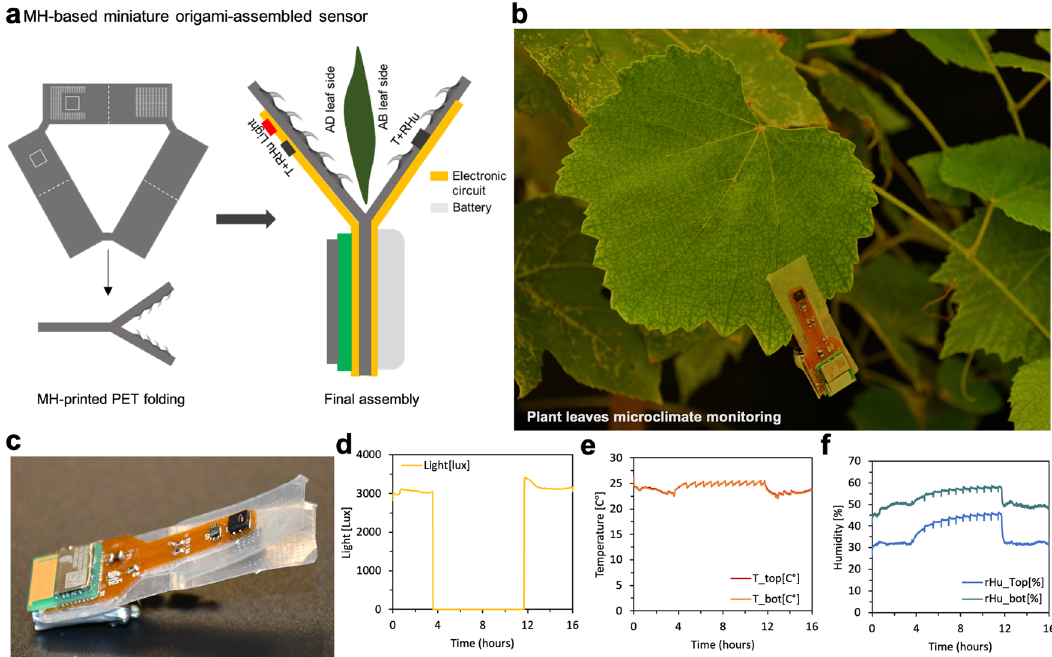
Fig. 3 Environmental machines made with fl exible IPS-MHDs. a A fully integrated origami-assembled device embedding microprinted hooks, electronic circuit, sensors, and battery. b, c Pictures of MH-based sensor for leaf microclimate monitoring. d – f Plotting results of light, temperature, and humidity parameter monitoring of V. lambrusca leaves in growth chamber conditions over 16 h. Temperature and humidity parameters are reported for both adaxial and abaxial V. lambrusca leaf